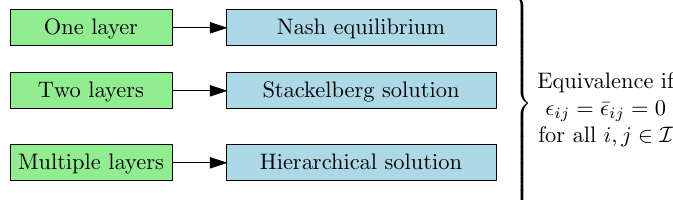
Figure 1. Different hierarchical designs and their solution concepts considered in this paper.